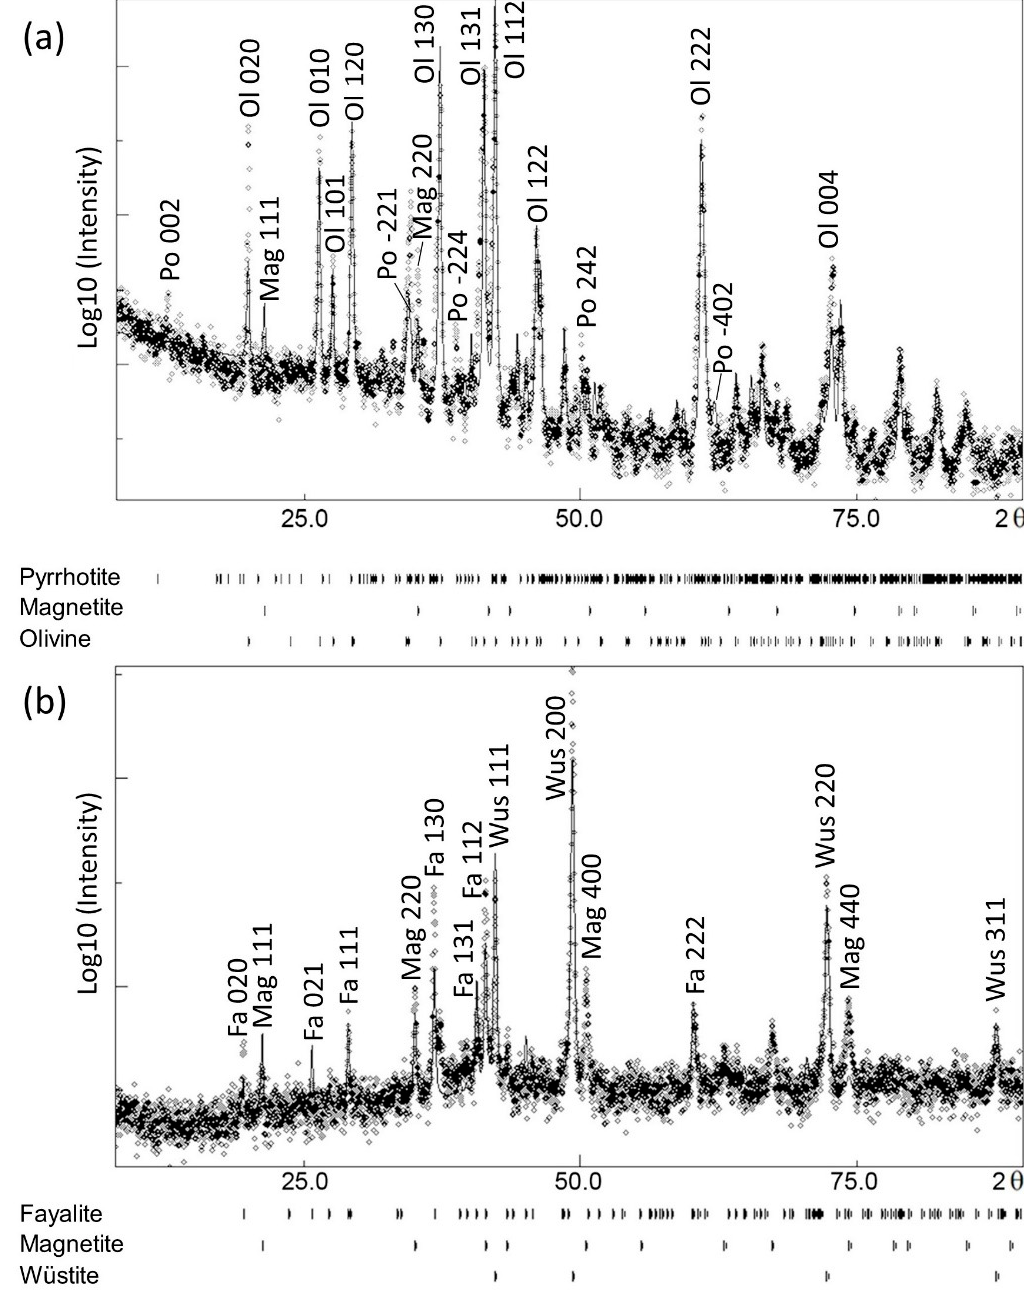
Figure 3. XRD patterns of Casaccia slags plotting intensity (logarithmic scale) as function of 2 θ ; Co-K α -radiation. ( a ) Non-magnetic; ( b ) magnetic. Dots are measured data and line is Rietveld fit. Some peaks are identified. Phase abbreviations refer to the IUGS convention [35].